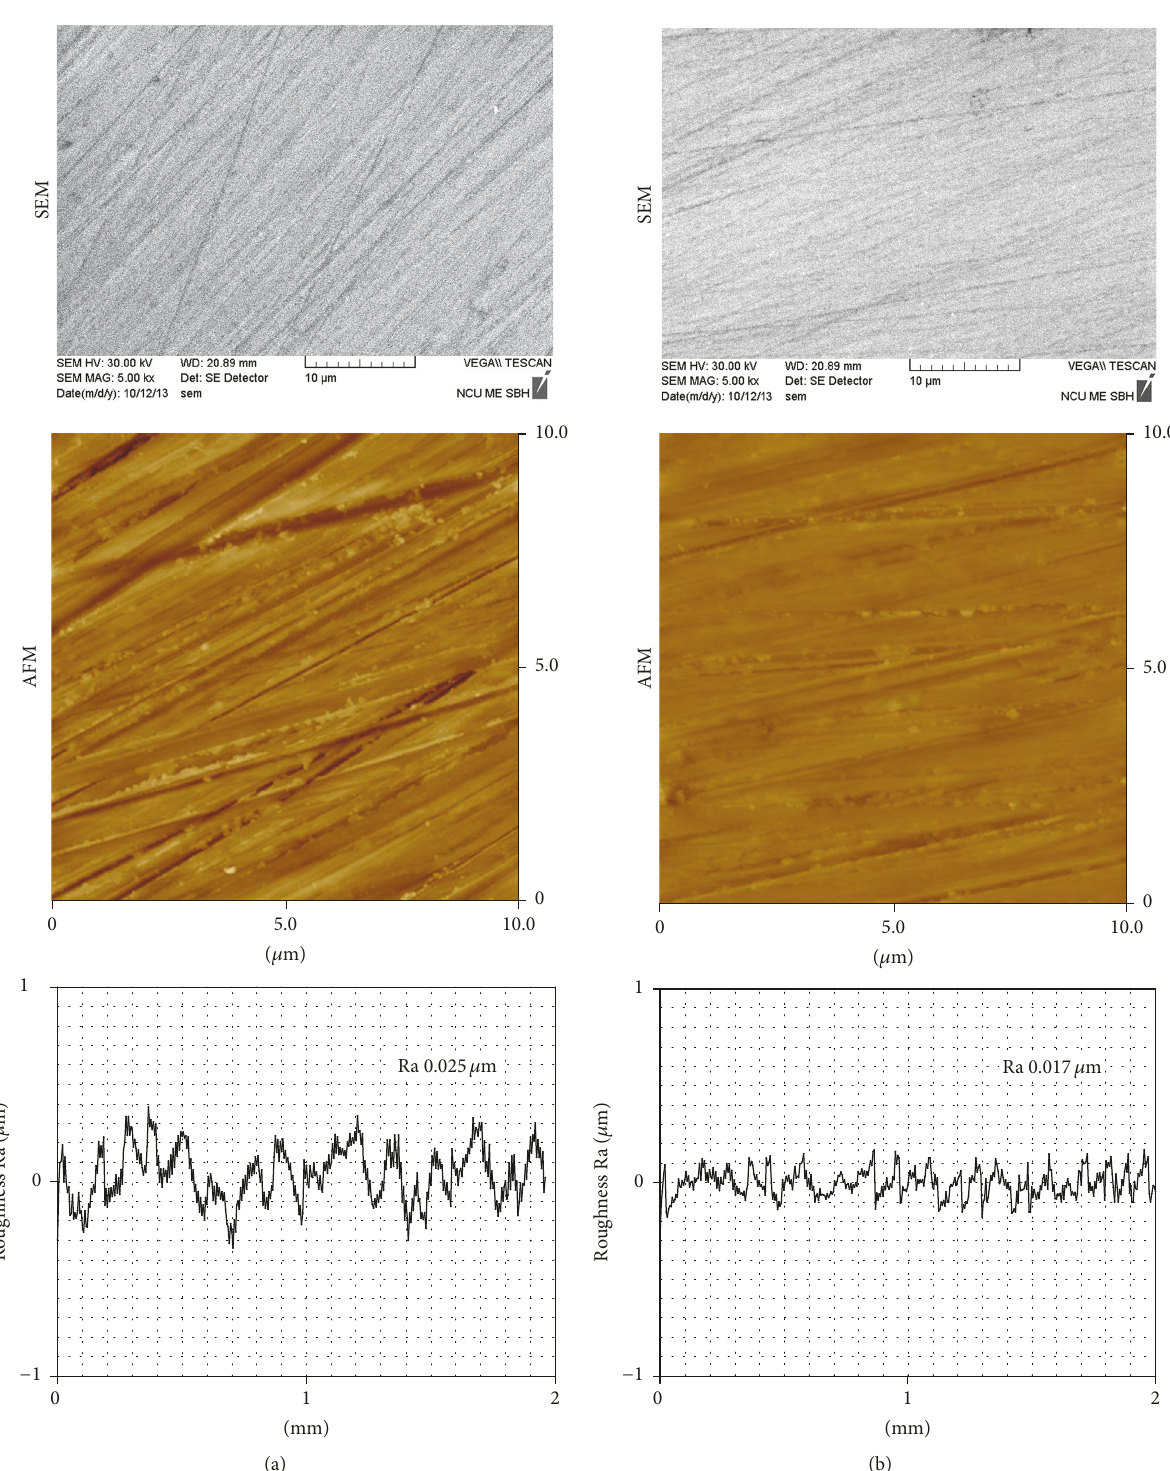
Figure 8: Comparison of polished specimen after (a) bamboo charcoal polishing (b) UV bamboo charcoal